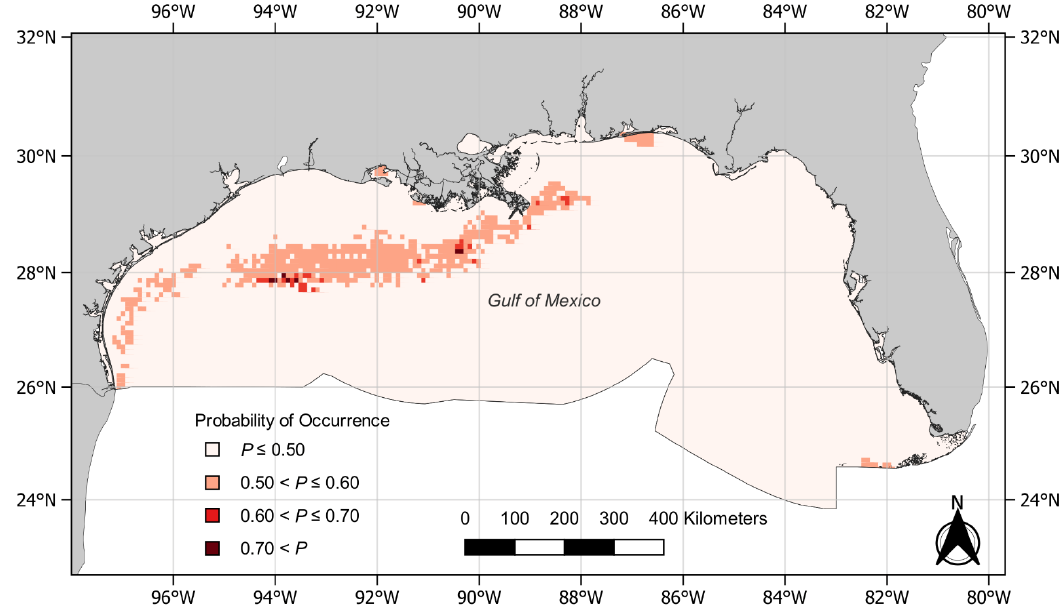
Figure 4. Estimated probabilities of Tubastraea coccinea occurrence in the northern Gulf of Mexico.